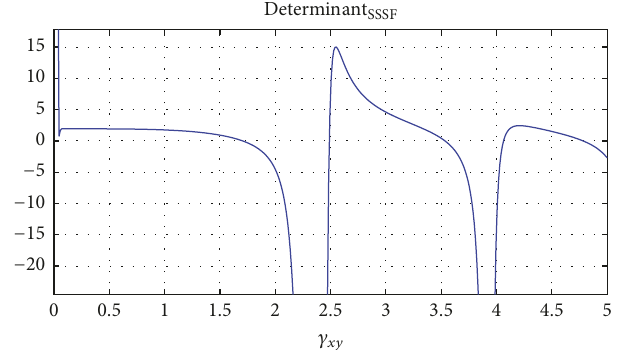
Figure 3: Plot of transcendental DFE determinant function for SS- SS-SS-F boundary condition against 𝛾 𝑥𝑦 = (𝜌𝑡𝜔 2 /𝐷) 1/4 .